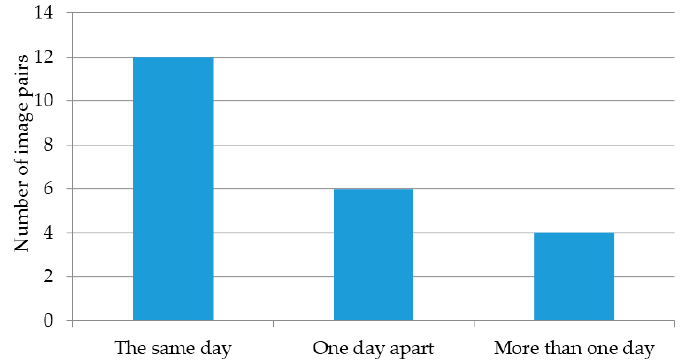
Figure 2. Statistical results of the time lags between optical and SAR images.